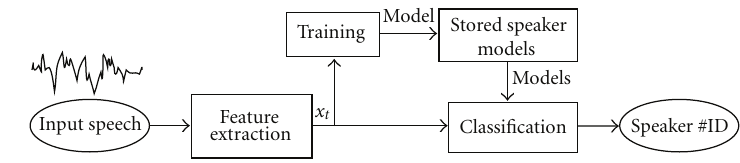
Figure 1: Top-level structure of speaker identification system.